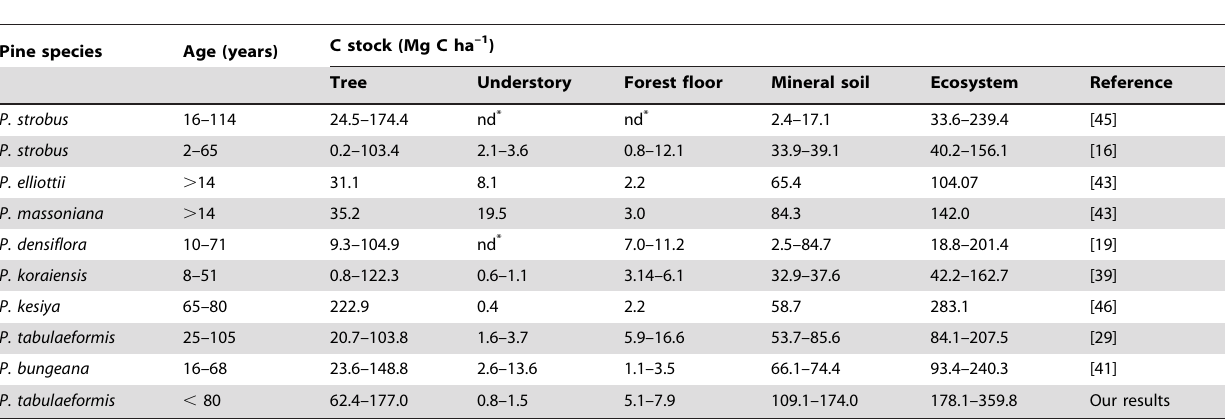
Table 7. Comparison of C storage between P. tabulaeformis and published results of pine species.